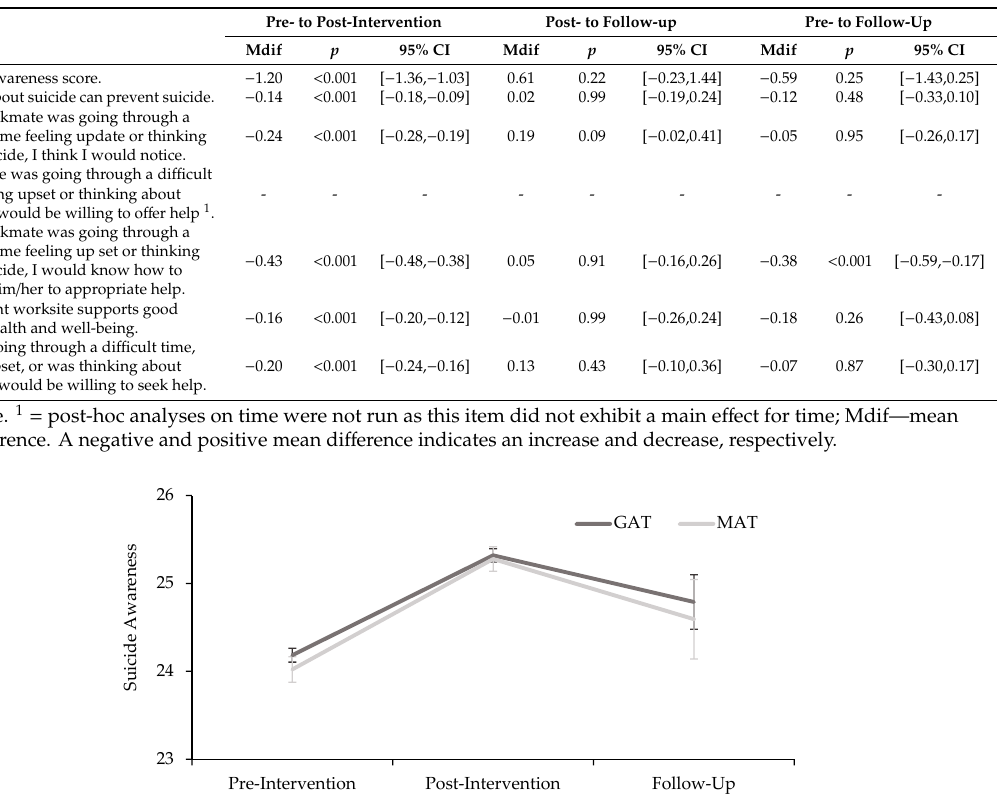
Figure 1. Estimated marginal means for intervention (general awareness training (GAT) and MATES awareness training (MAT)) and time (pre, post, and follow-up) on suicide awareness. Error bars represent standard errors.